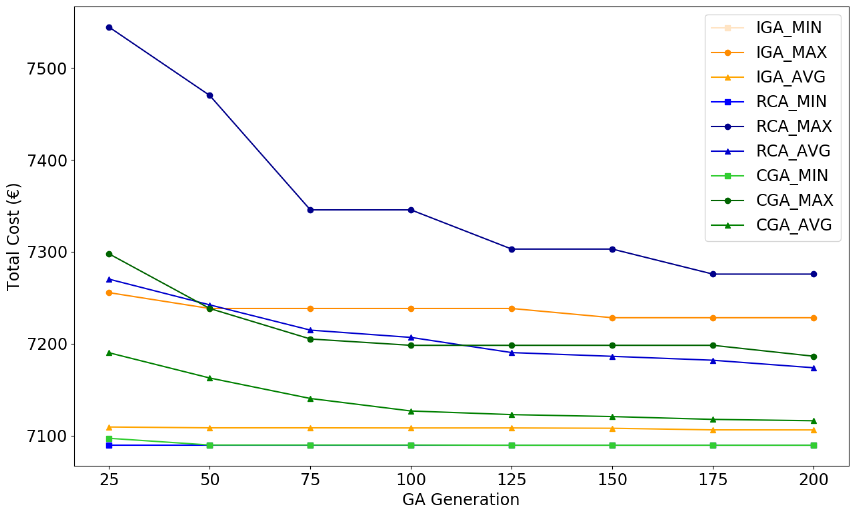
Figure 10. Minimum, maximum, and average of total cost as a function of generations of IGA, CGA, and